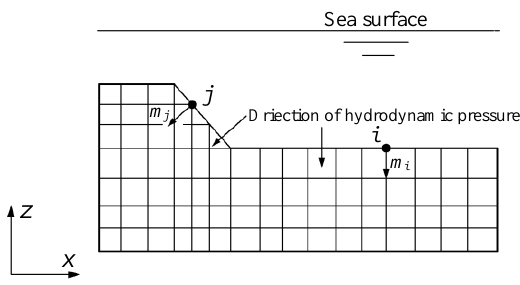
Figure 10. Sketch drawing of seabed surface hydrodynamic pressure decomposition.